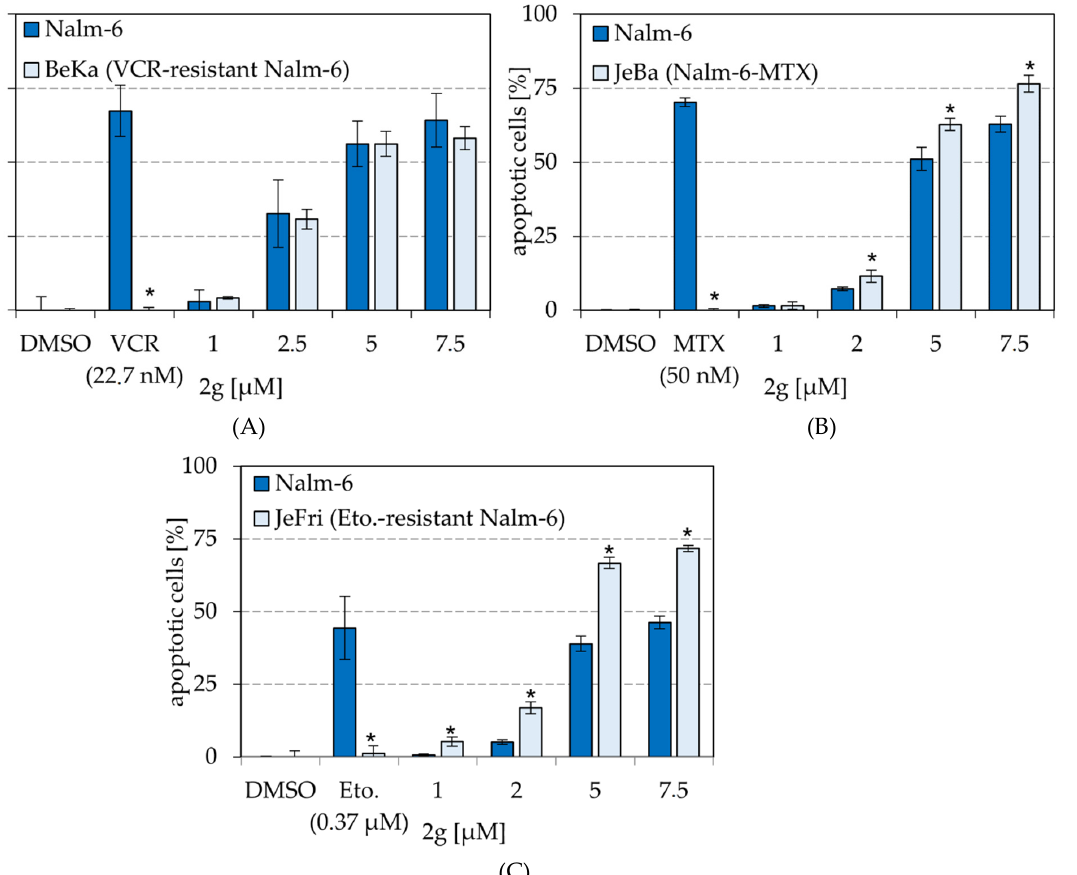
Figure 8. Resistance overcoming by 2g . Nalm-6 cells as well as their corresponding resistant cell lines were treated with 2g for 72 h. DMSO was used as the solvent. The cytostatic drugs were used to prove the resistance of the cells (( A ): VCR—vincristine, ( B ): MTX—methotrexate, ( C ): Eto.—etoposide). After treatment, the induction of apoptosis was measured via flow cytometric analysis of DNA fragmentation. Three replicates were carried out per concentration. The mean values ± SD are shown (* p < 0.05 vs. corresponding concentration in Nalm-6, t -test). Leukocytes than in Nalm-6